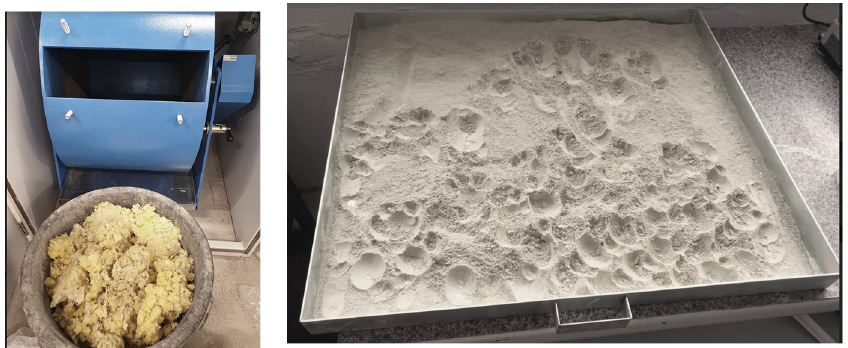
Figure 2. A view of a Los-Angeles drum and ground wool.